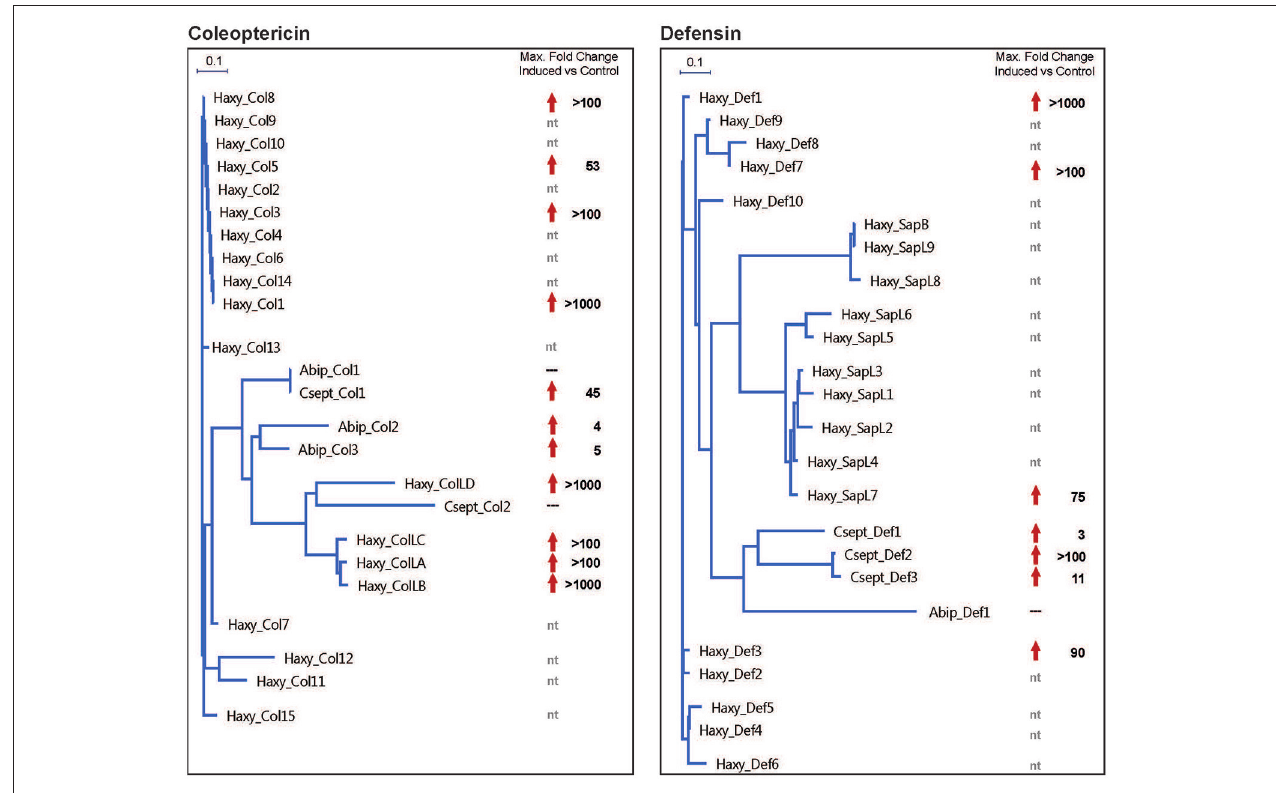
FIGURE 1 | Coleoptericin and defensin gene trees and maximum induction levels after an immune challenge in three ladybeetle species. (A) Evolutionary relationships and gene expression changes among the coleoptericin proteins. (B) Evolutionary relationships and gene expression changes among the defensin proteins. The alignments were created using MAFFT and gene trees were built using the BioNJ algorithm implemented in MegAlignPro. The distance scale is shown at the top left. Differential gene expression values are shown for a selected set of coleoptericins and coleoptericin-like genes (A) or defensins and defensin-like genes (B) and are shown as fold changes following an immune challenge vs. untreated control beetles. Red arrows indicate higher gene expression levels in immune-challenged beetles whereas dashes indicate no change. Nt, not tested; Haxy, Harmonia axyridis; Abip, Adalia bipunctata; Csept, Coccinella septempunctata